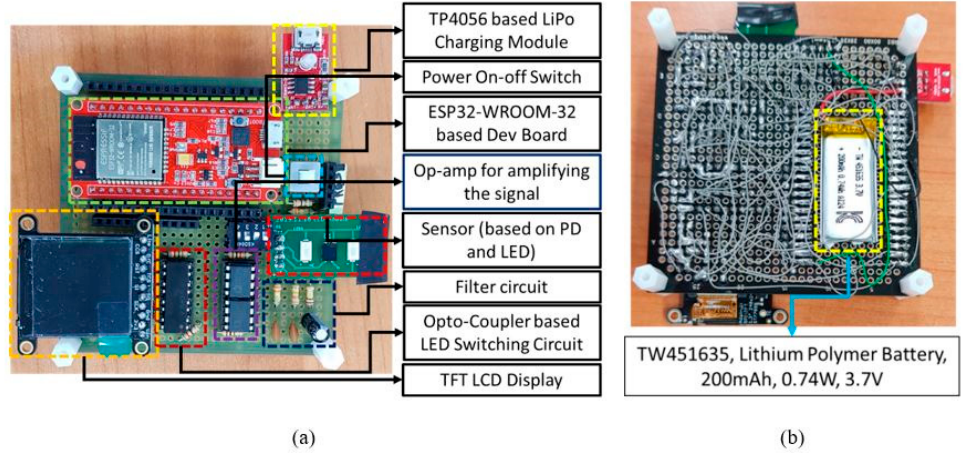
Figure 17. Hardware implementation of the proposed electronic circuit: ( a ) top view and ( b ) bottom view of the PO device. TFT, thin ‐ film ‐ transistor; LCD, liquid crystal display.